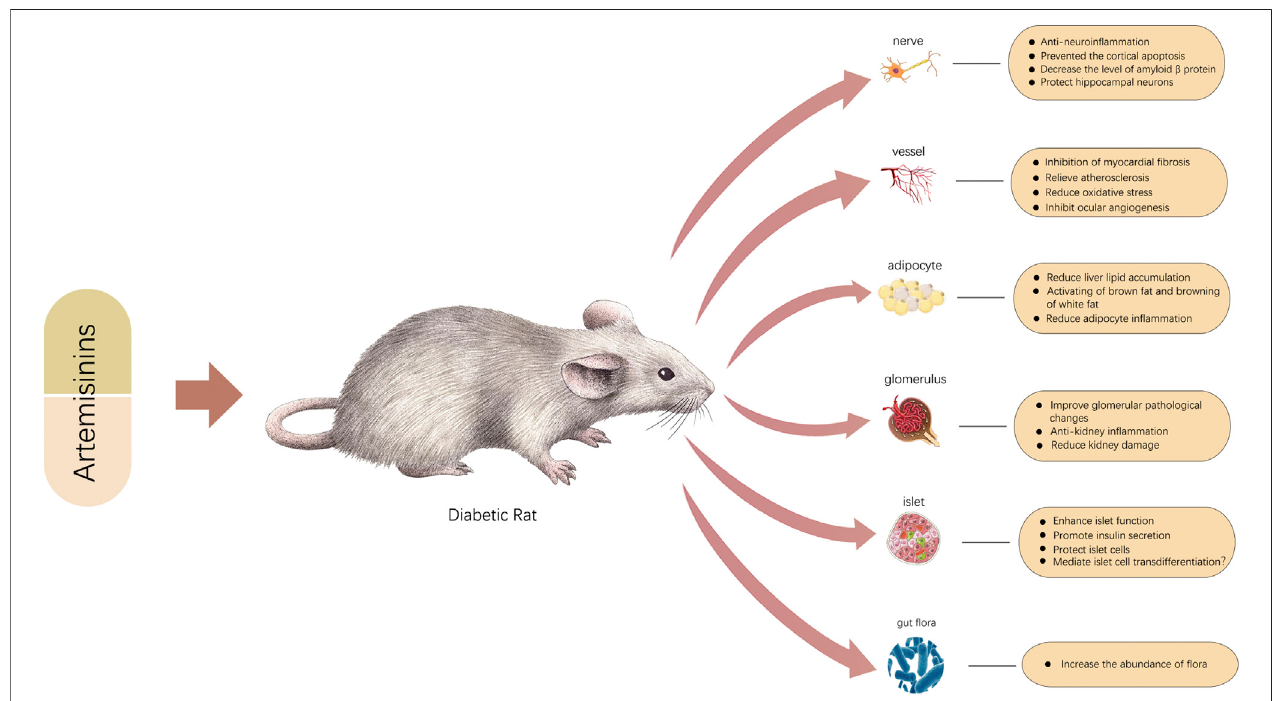
FIGURE 2 | Graphic